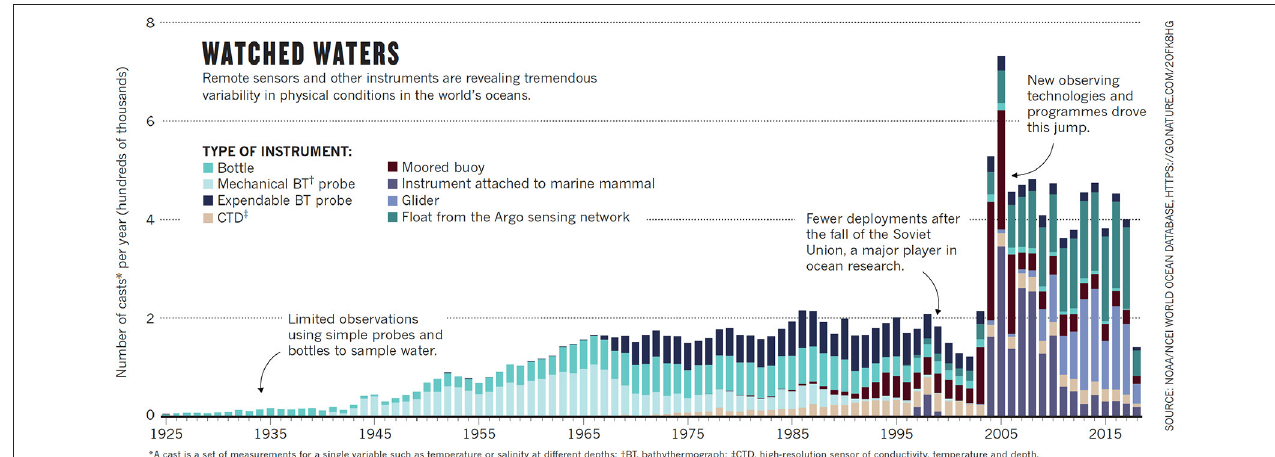
FIGURE 3 | The growth of the number of temperature and/or salinity profiles per year since 1925. The type of data is coded by the colors. Relatively steady levels of ocean sampling held from the mid-1960s to the mid-2000s, when new technology roughly doubled the number of profiles obtained from near 200,000 per year to 400,000 per year. Figure from Bates et al.